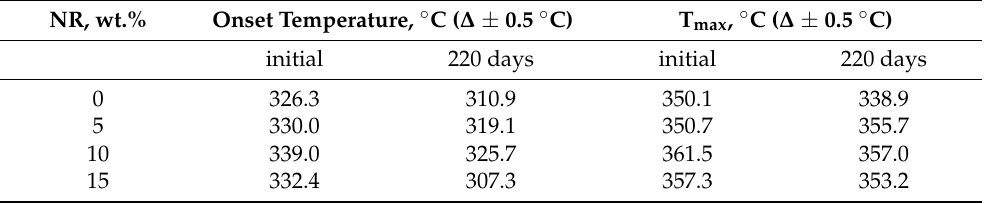
Table 3. Thermal degradation of PLA and PLA/NR samples: before and after 220 days of soil exposure.